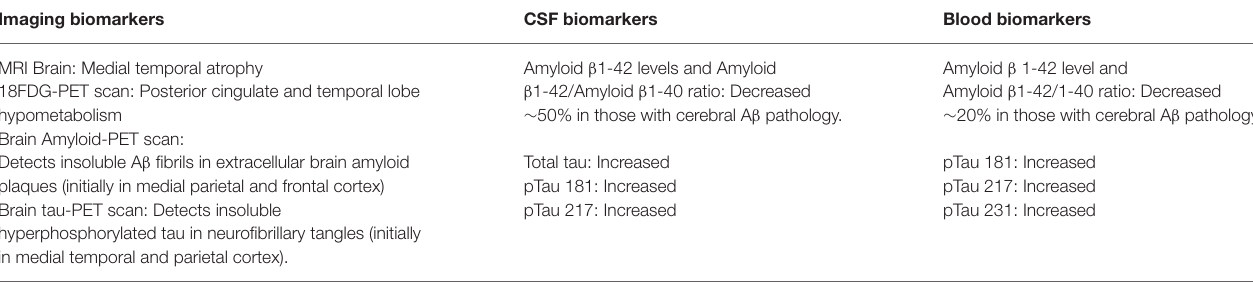
TABLE 1 | Current and proposed tests for accurate and early detection of Alzheimer’s disease. Imaging biomarkers CSF biomarkers Blood biomarkers MRI Brain: Medial temporal atrophy 18FDG-PET scan: Posterior cingulate and temporal lobe hypometabolism Brain Amyloid-PET scan: Detects insoluble A β fibrils in extracellular brain amyloid plaques (initially in medial parietal and frontal cortex) Brain tau-PET scan: Detects insoluble hyperphosphorylated tau in neurofibrillary tangles (initially in medial temporal and parietal